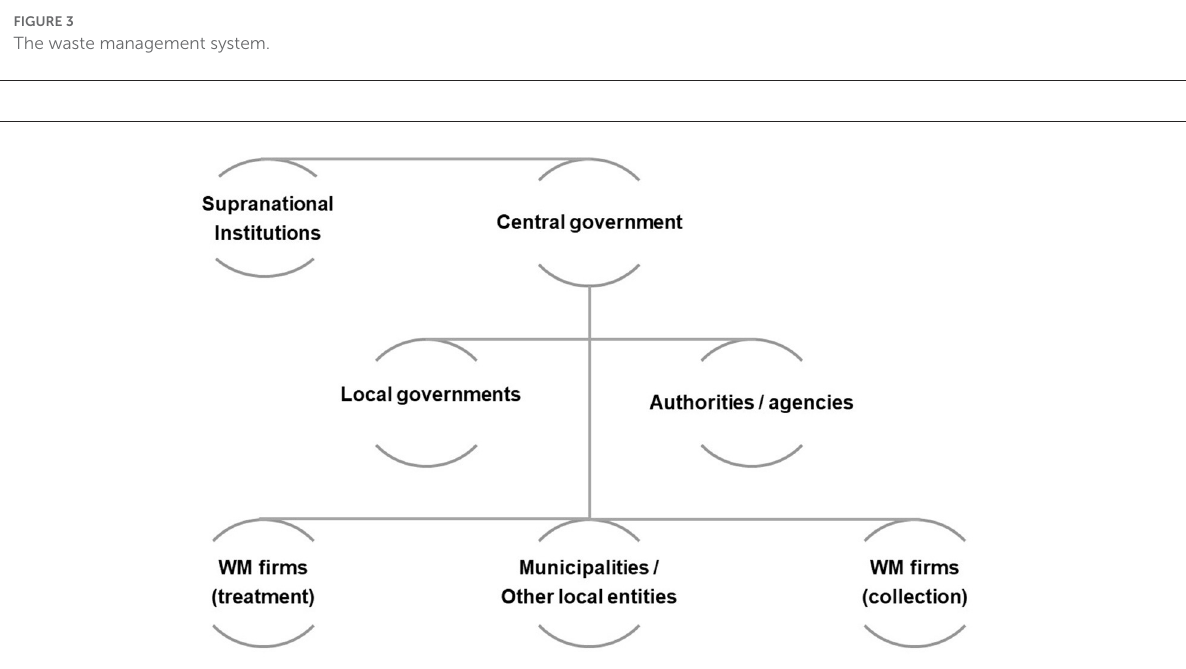
FIGURE4 Multi-level governance